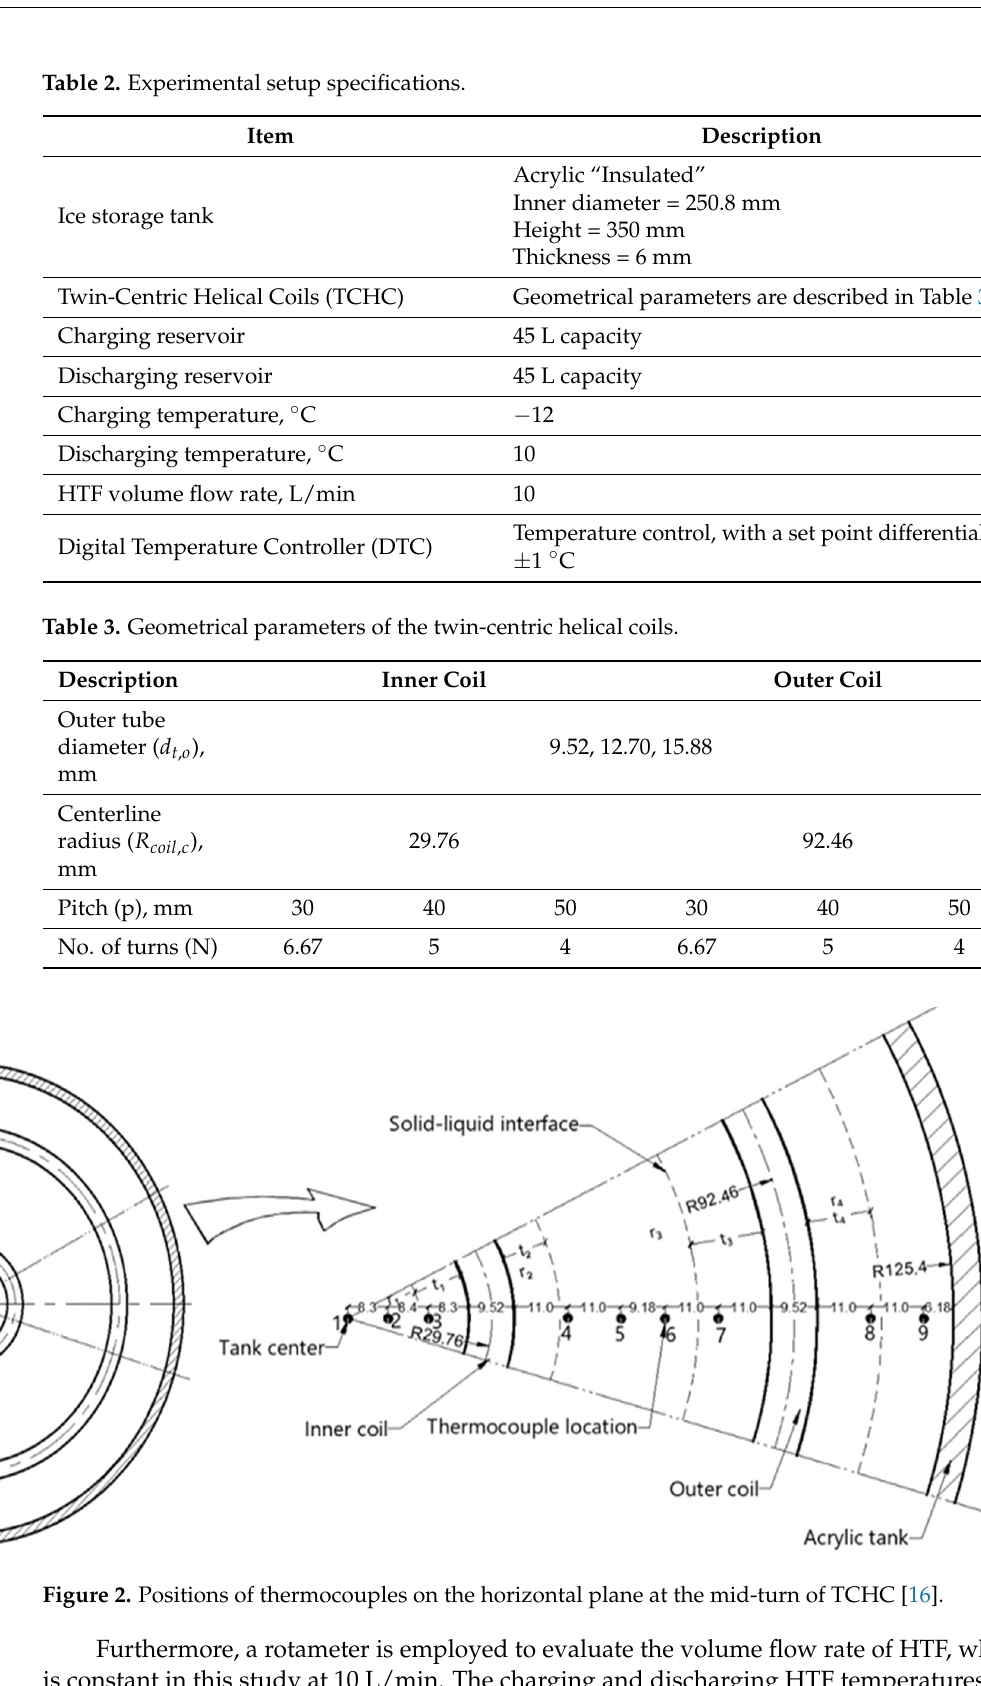
Table 2. Experimental setup specifications.